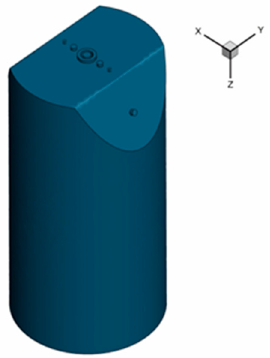
Figure 4. Computational domain of paint atomization simulation.